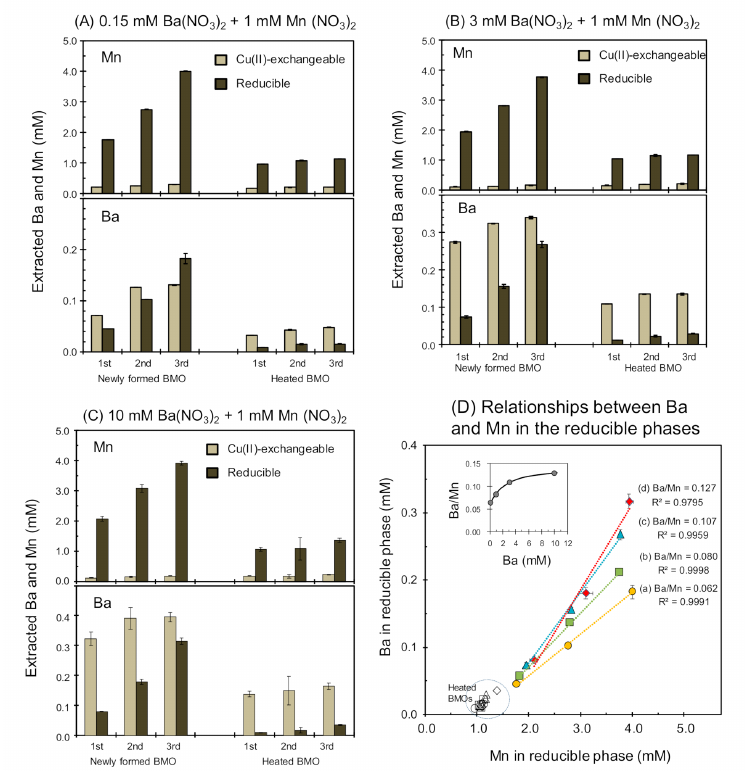
Figure 2. Diagram showing the two-step extraction of Ba 2+ and Mn from the newly formed and heated biogenic manganese oxides through repeated treatment with mixtures of ( A ) 0.15 mM, ( B ) 3 mM, and ( C ) 10 mM Ba(NO 3 ) 2 with 1 mM Mn(NO 3 ) 2 in 20 mM HEPES (pH of 7.0). ( D ) Plot displaying linear relationships between the extracted Ba and Mn in reducible phases, with the inset showing the Ba/Mn molar ratios as a function of the initial Ba 2+